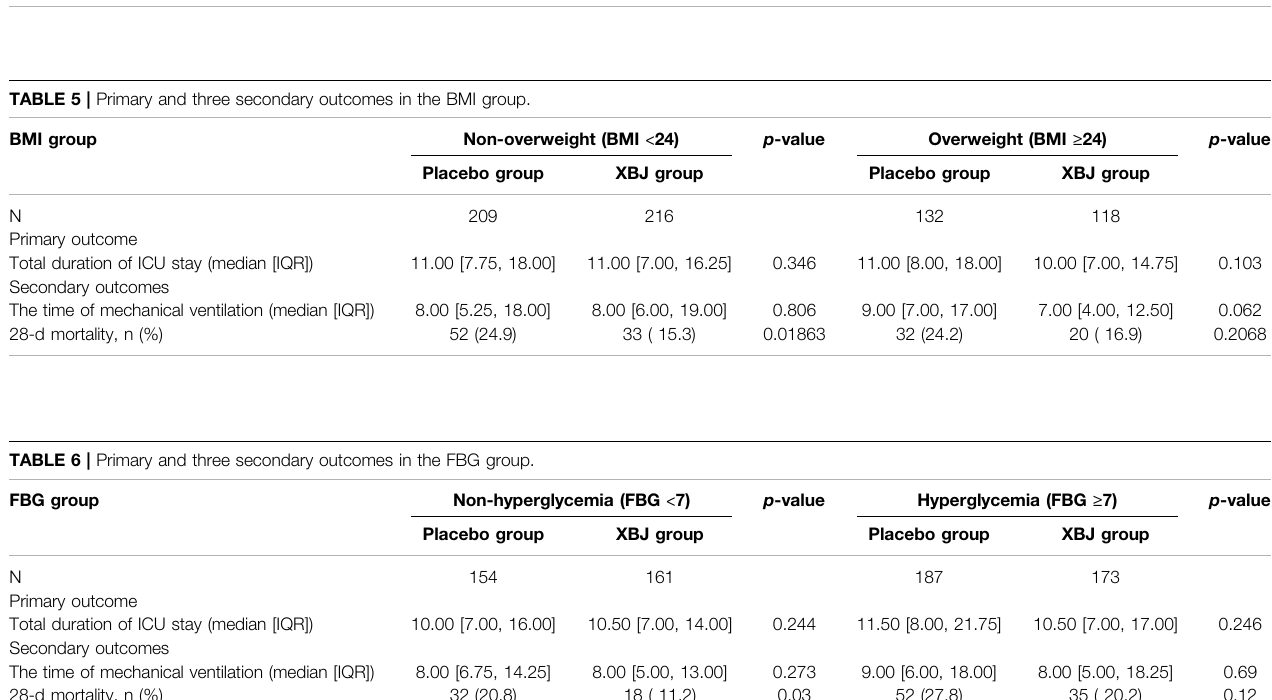
glucose-induced alterations in endothelial cell function promote changes in the basement membrane structure and cause endothelial cell permeability; reactive oxygen species (ROS) have